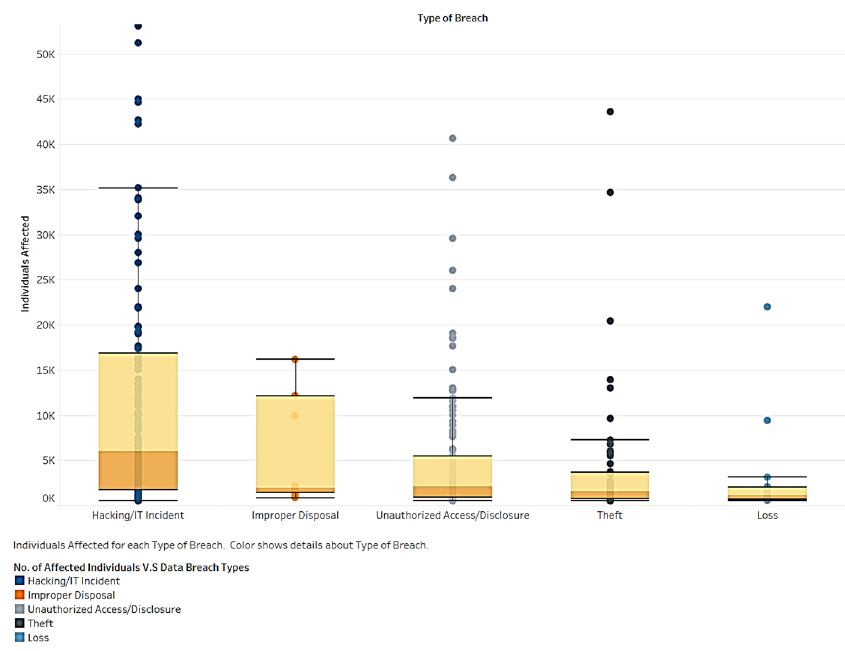
Figure 2. Analysis of affected individuals vs. breach type.